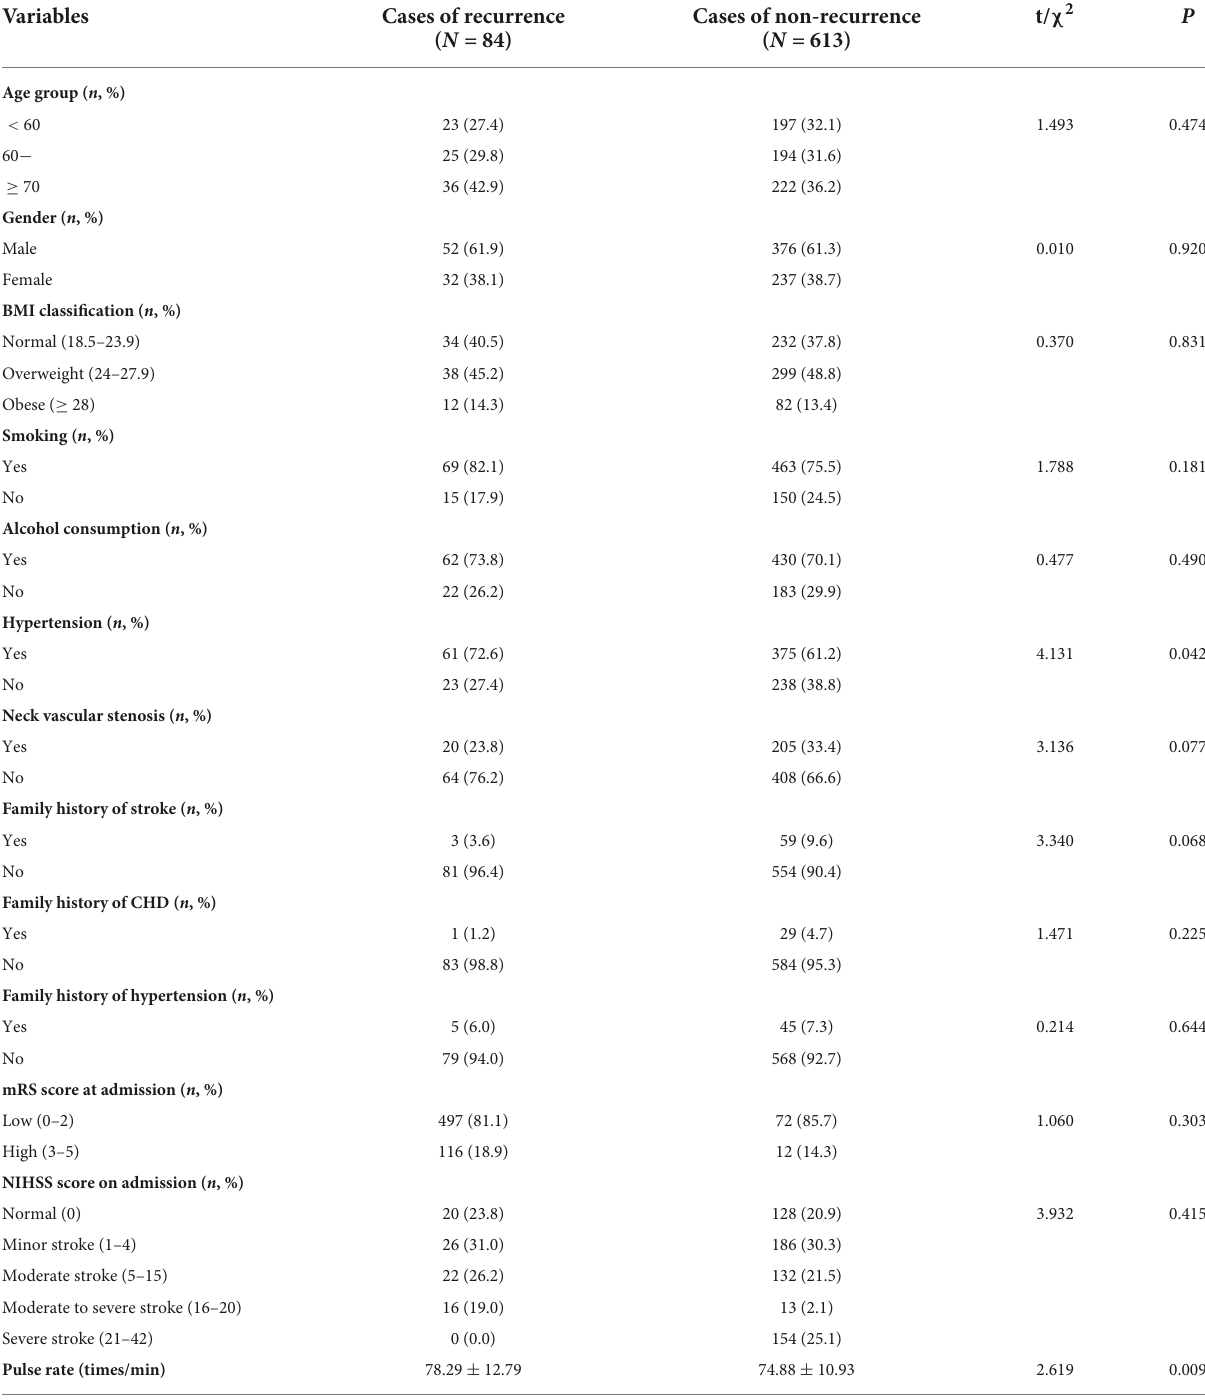
TABLE 1 Baseline data of